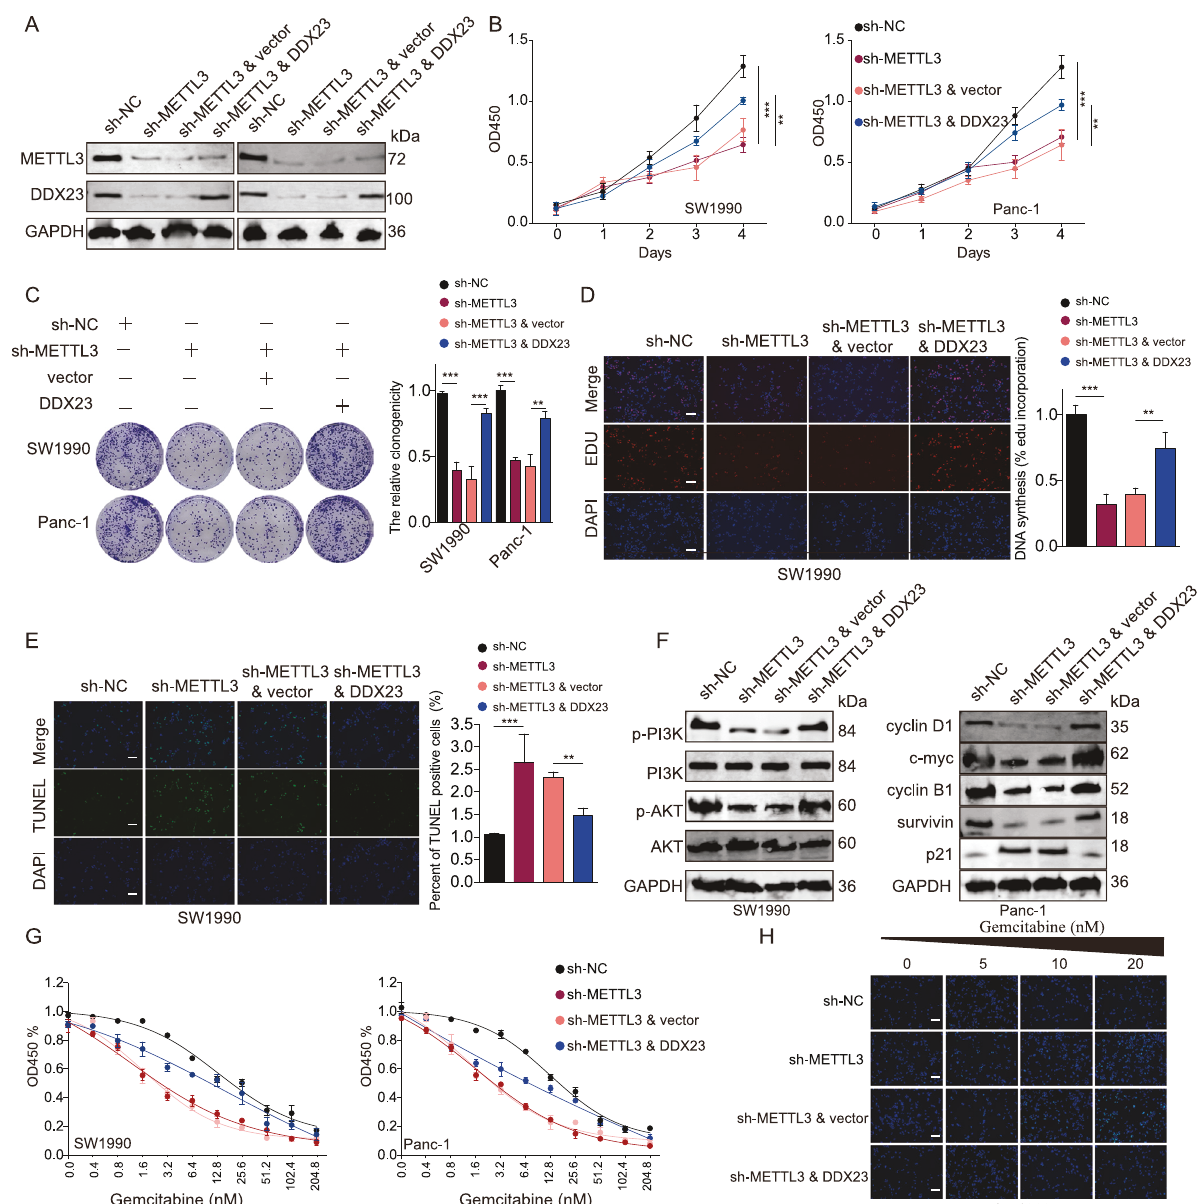
Fig. 7 The effects of METTL3 knockdown were restored by the simultaneous upregulation of DDX23. A The knockdown of METTL3 and overexpression of DDX23 were con fi rmed at the translational level. B The suppressed OD values of the two cell lines by METTL3 knockdown were restored by the simultaneous overexpression of DDX23. C , D The suppressed cell proliferation resulting from METTL3 silence was partially restored by DDX23 upregulation. E The elevated cell apoptosis resulting from METTL3 knockdown was partially reversed by DDX23 demonstrated by the TUNEL assay. F The knockdown of METTL3 led to suppressed PI3K and Akt phosphorylation as well as cell cycle-related proteins, which were elevated by DDX23 overexpression. G , H DDX23 overexpression enhanced GEM resistance of cells with METTL3 knockdown, demonstrated by CCK8 assay ( G ) and TUNEL assay ( H ). ** P < 0.01, *** P < and resuspended in the medium containing FBS. The cells were then seeded into the Transwell inserts in triplicate to be allowed to migrate into the lower chambers that were fi lled with the DMEM medium containing 10% FBS (as the attractant). 36 h later, the cells on the lower surface were fi xed and stained. Five random microscopic fi elds were selected and photographed. The stained cells in every fi eld were counted. The wound- healing assay was employed to determine the migration capability of cells. Brie fl y, cells with different treatments were cultured to form monolayers in 6-well plates until 90 – 100% con fl uence. Thereafter, the cell layers were scratched with sterile plastic tips and washed with PBS to get rid of the loose cells. The cells were then cultured for a further 36 h and fi nally photographed using a microscope.